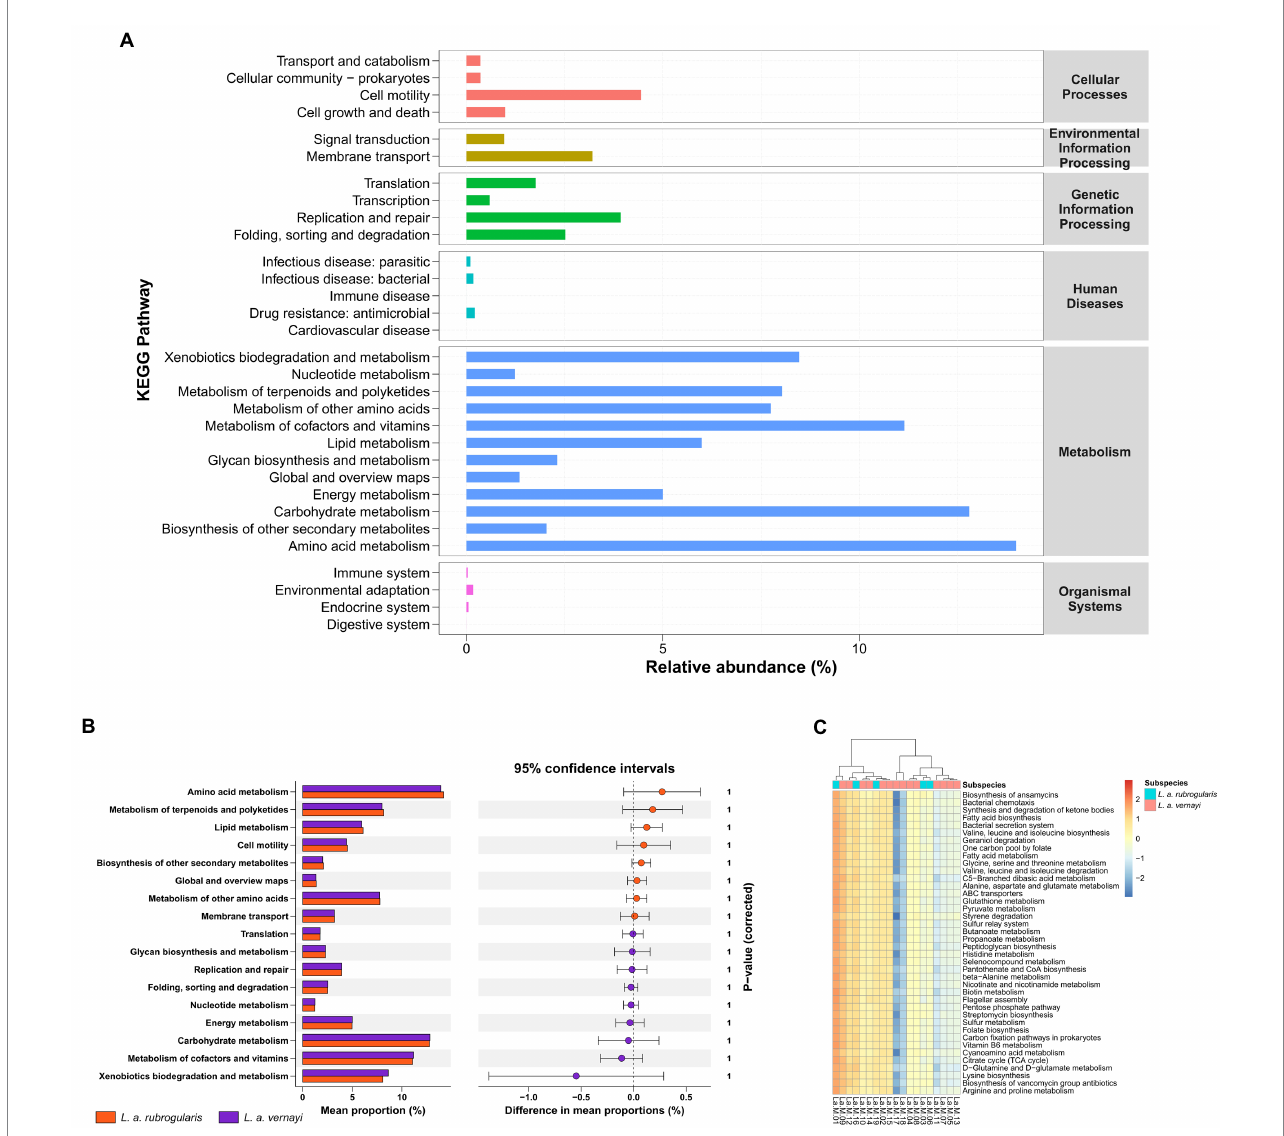
FIGURE 6 The prediction of metabolic function within the microbiome in L. a. rubrogularis and L. a. vernayi ( n = 19). (A) KEGG analysis of the relative abundance of metabolic pathways between L. a. rubrogularis and L. a. vernayi . The abscissa represents the relative abundance of functional pathways, the ordinate represents the functional pathways of the second classification level of KEGG, the rightmost box represents the first level to which the pathways belong. (B) Extended error bar plot to determine the significant difference in the predicted gene function between L. a. rubrogularis and L. a. vernayi . The middle value represents the mean differences between the groups (upper bar value – lower bar), and the error bar represents the 95% confidence intervals. The right side of the zero-point indicates the larger effect on the gene function in the L. a. rubrogularis , and the left side of the zero-point indicates the larger effect of that in the L. a. vernayi . p value at the side indicates the significance levels between the upper and lower bars. (C) Heatmap of the genus-level hierarchical clustering of the third level functional pathways in L. a. rubrogularis and L. a. vernayi